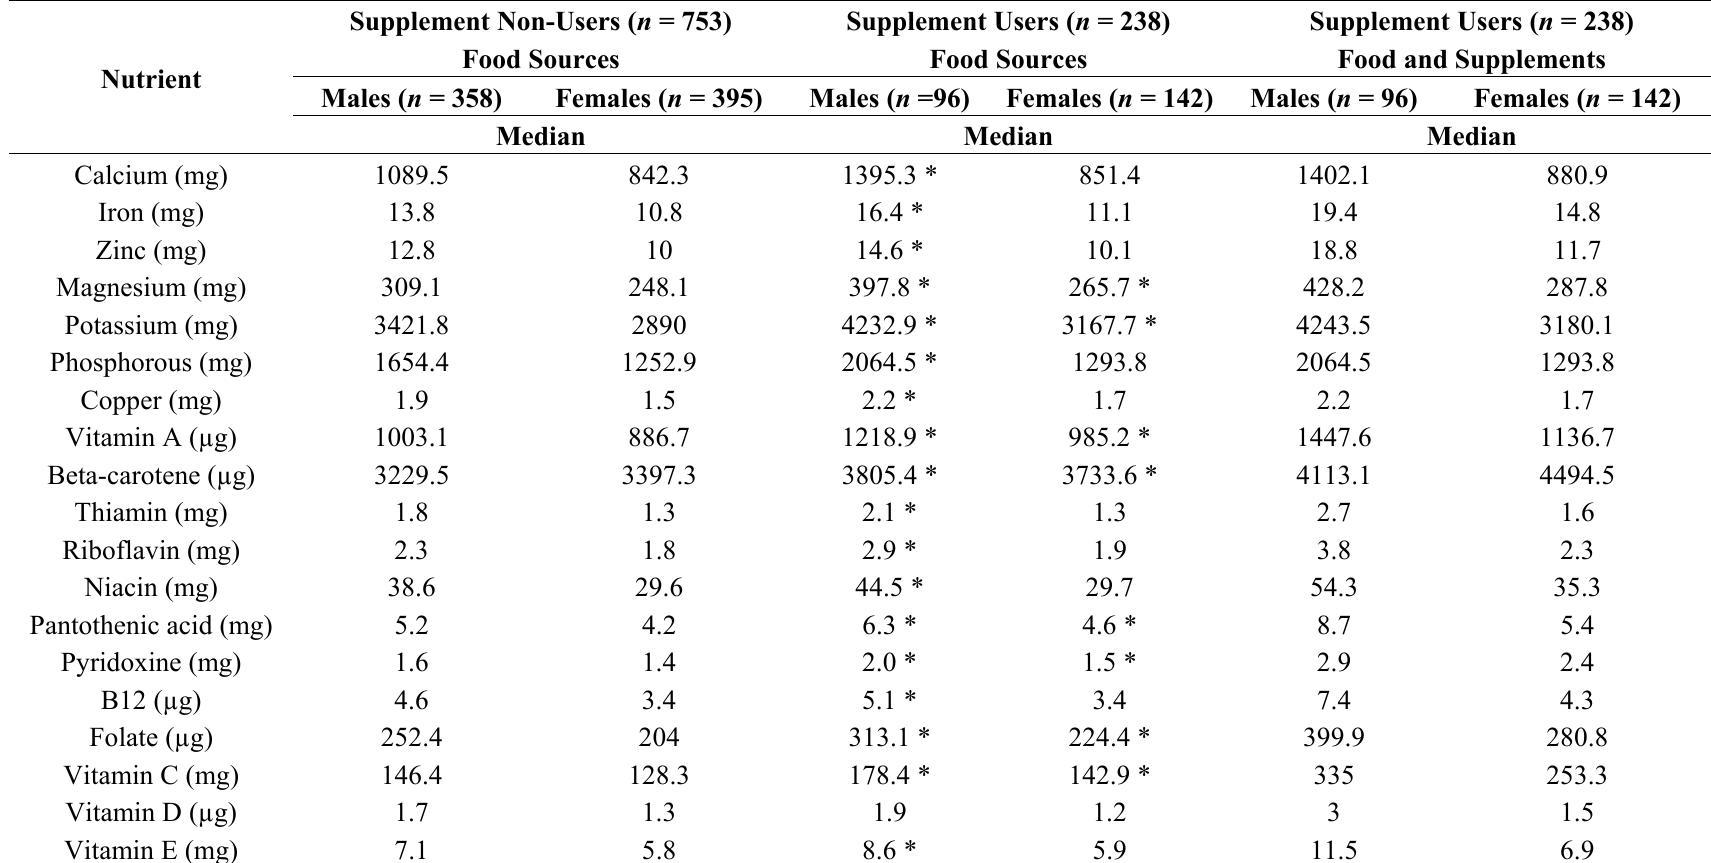
Table 3. Median daily micronutrient intakes from food and supplements in male and female supplement non-users ( n = 753) and users ( n = 238) in 17 year old adolescents in the Western Australian Pregnancy Cohort (Raine)